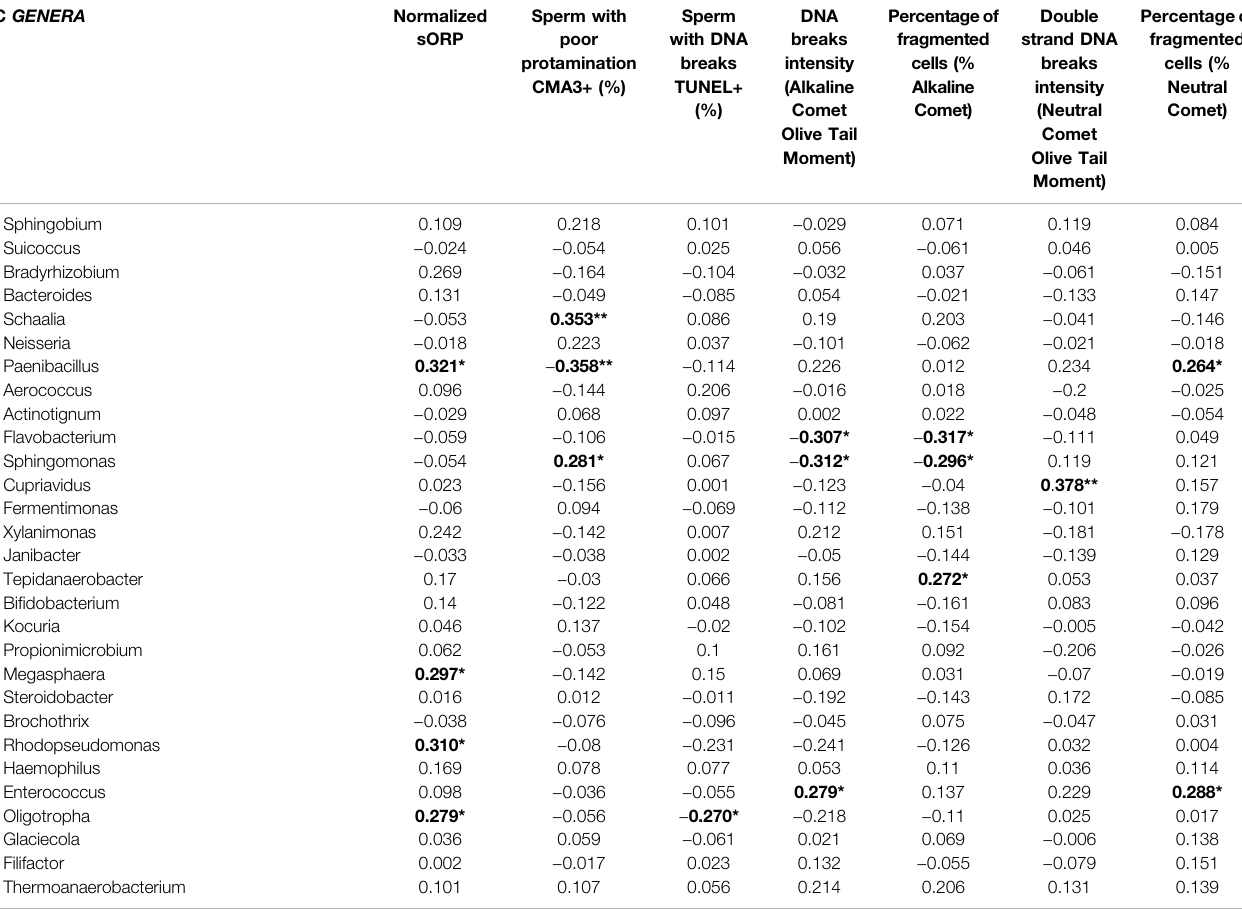
Labeled in bold are the statistically signi fi cant correlations. *Statistically signi fi cant correlations ( p < 0.05) ** Statistically signi fi cant correlations ( p <